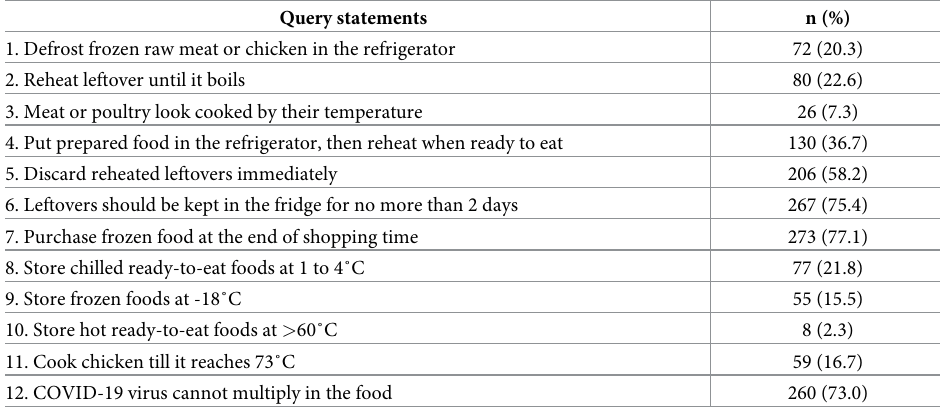
Table 5. Query statements and responses 1 of the “temperature control” aspect (n =